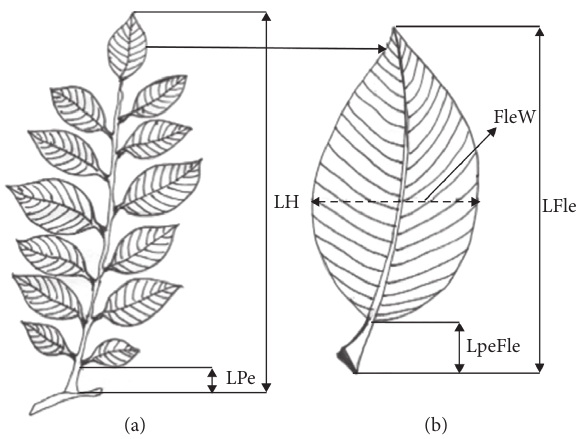
Figure 4: Measurement of leaf (a) and leaflet (b) of P. erinaceus (drawing: Johnson B.